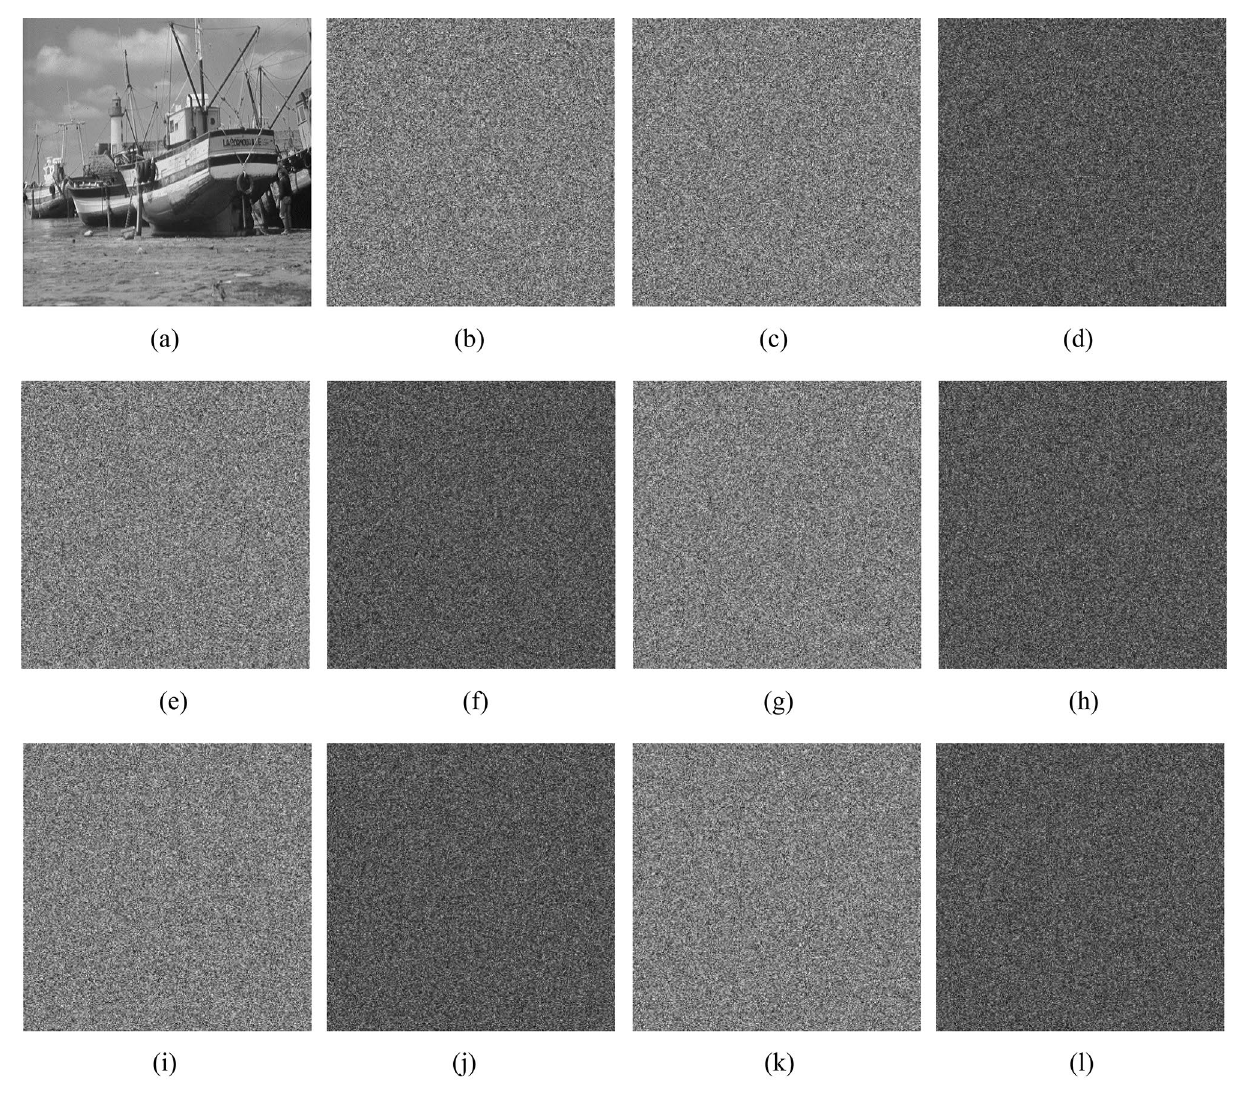
Figure 12. Keys sensitivity. ( a ) Original image of Boat.512, ( b ) encrypted image of Boat.512 using original μ = 9, α = 0.85, r = 0.25, x 0 = 0.30565487923280 and ε = 0.39, ( c ) encrypted image of Boat.512 using changed μ = 9.0000000001, ( d ) difference between ( b ) and ( c ). ( e ) encrypted image of Boat.512 using changed α = 0.8500000001, ( f ) difference between ( b ) and ( e ). ( g ) encrypted image of Boat.512 using changed r = 0.2500000001, ( h ) difference between ( b ) and ( g ). ( i ) encrypted image of Boat.512 using changed x 0 = 0.30565487923281, ( j ) Difference between ( b ) and ( i ), ( k ) encrypted image of Boat.512 using changed ε = 0.3900000001, ( l ) difference between ( b ) and ( k